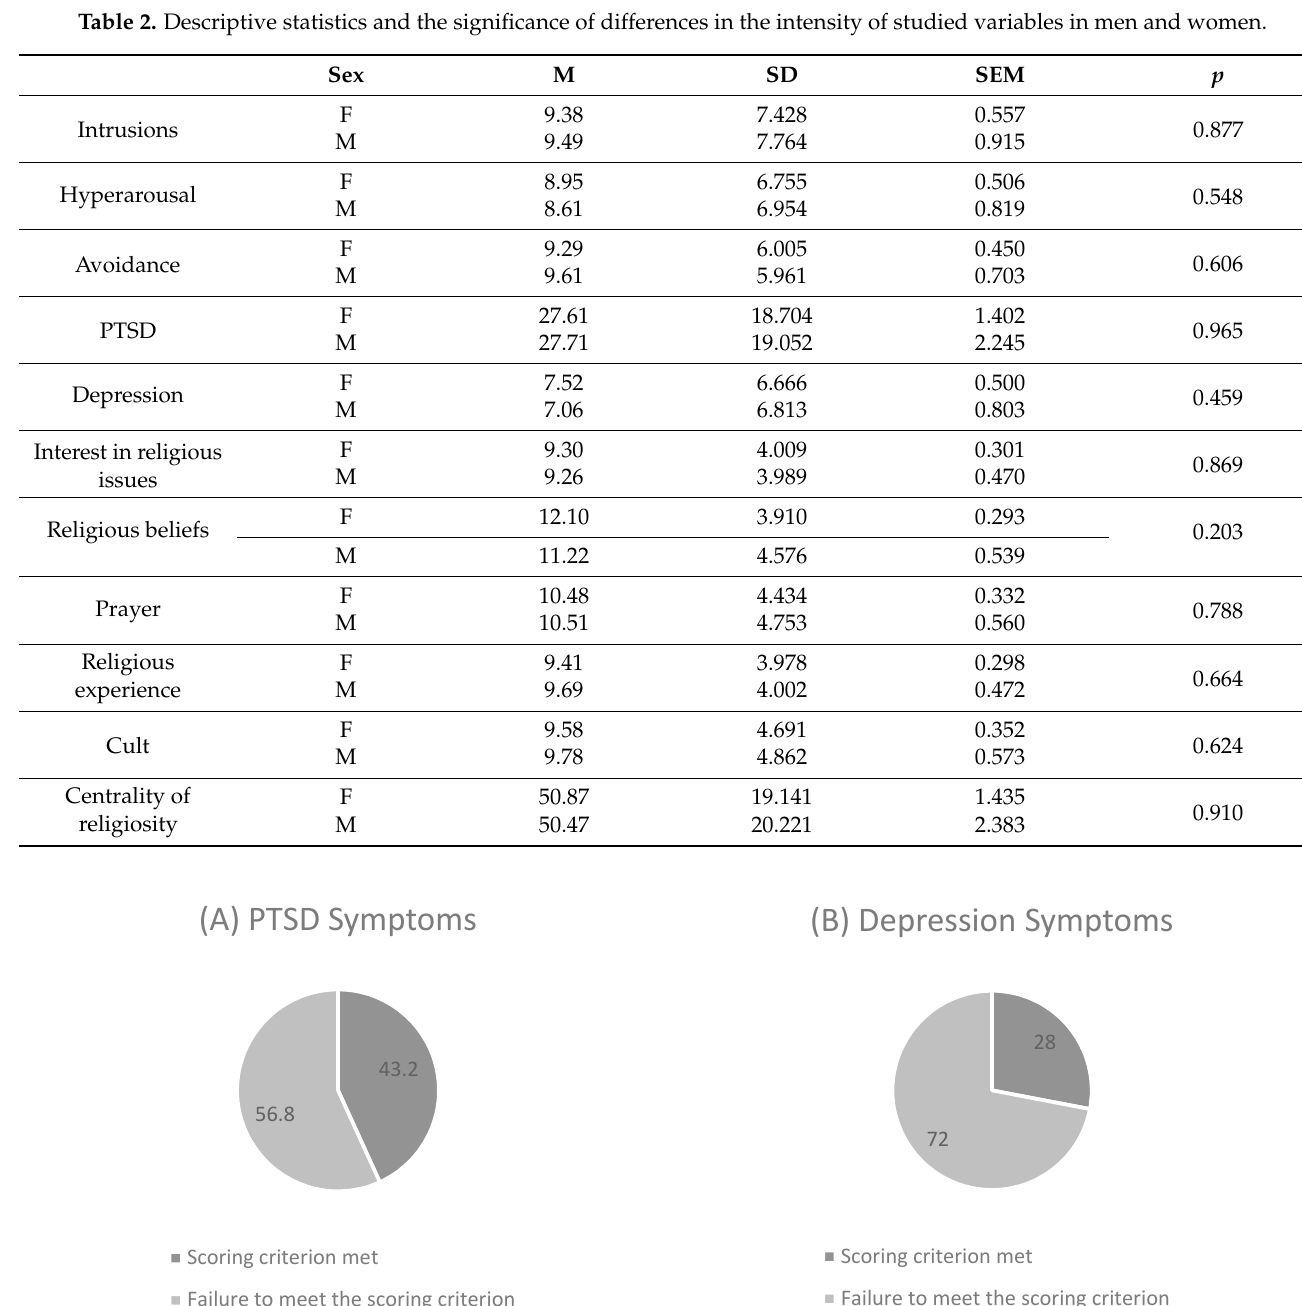
Figure 1. Clinical diagnosis of the symptoms of PTSD ( A ) and depression ( B ) in the study group.